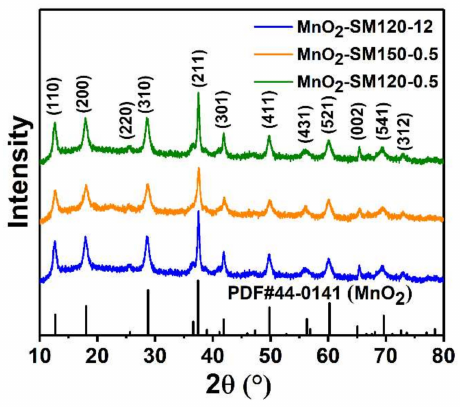
Figure 2. XRD patterns of MnO 2 -SM120-12 (green line), MnO 2 -SM120-0.5 (blue line), and MnO 2 -SM150-0.5 (orange line), the standard PDF card of MnO 2 (PDF#44-0141) is carried out for